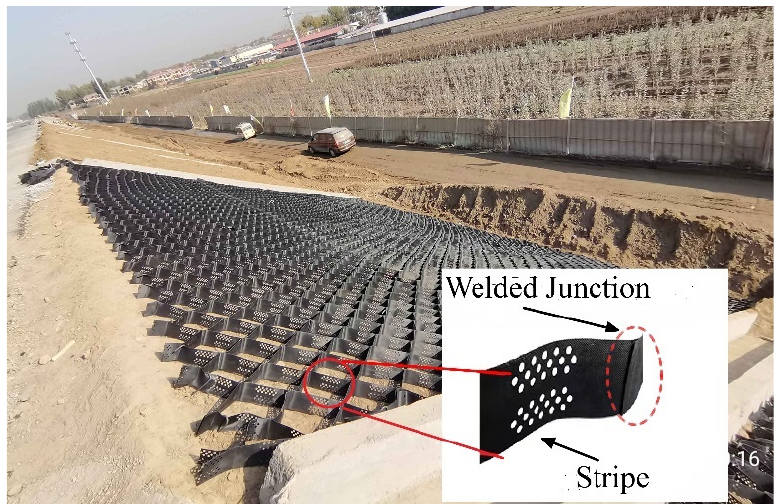
Figure 2. Geocell products for testing. Table 1. Specifications of the geocell.